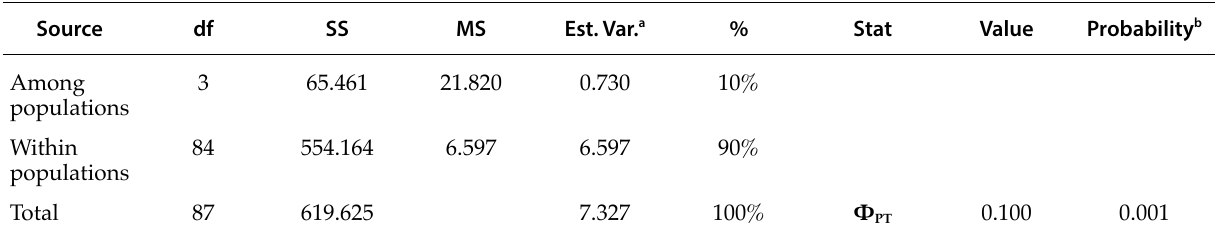
Table 4. Summary of analysis of molecular variance (AMOVA) of Fusarium culmorum isolates from wheat fields in four populations from